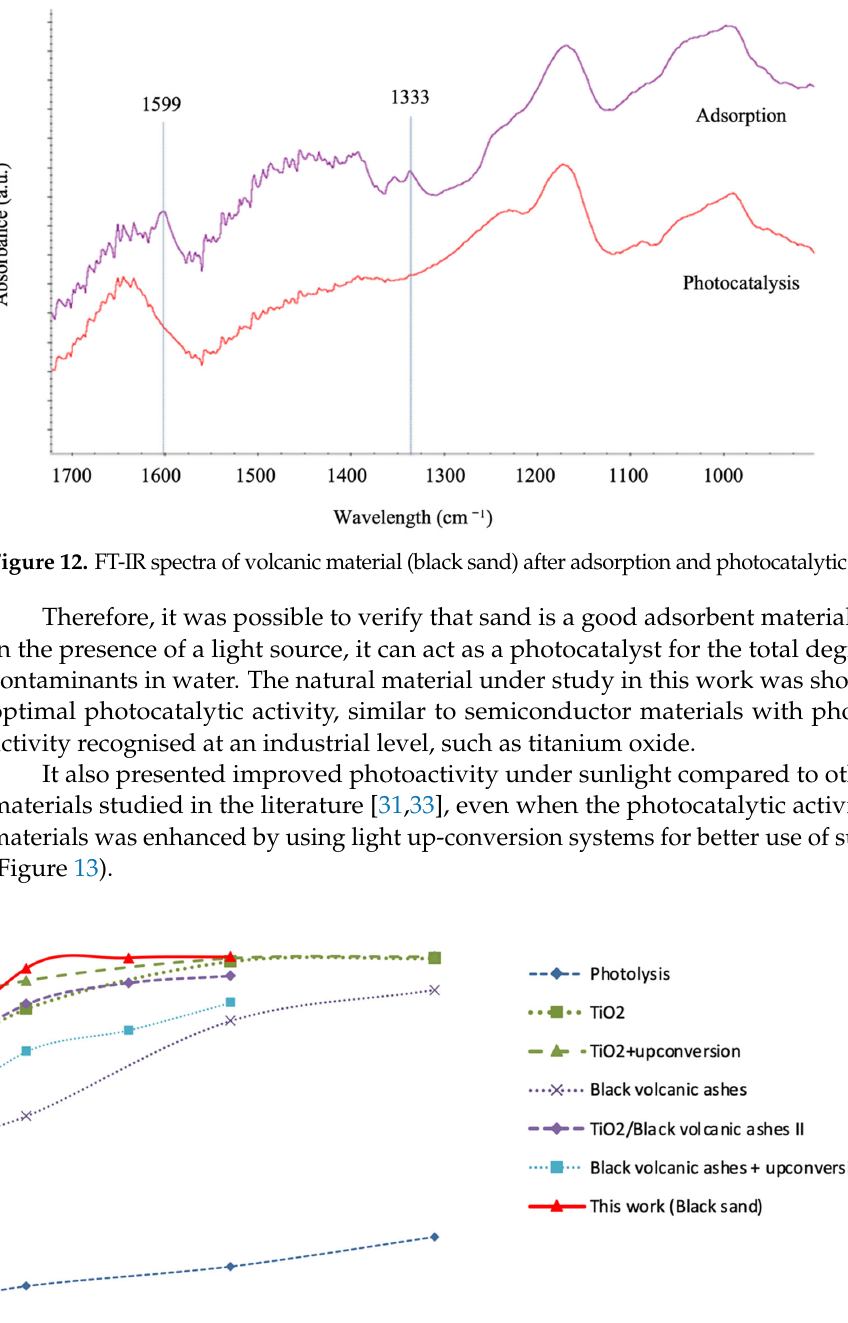
11 of 15 Figure 11. Pollutant in wastewater removal/degradation by adsorption/photocatalysis. The photocatalytic degradation of the contaminant due to the activation of the pho ‐ tocatalytic material by the input of light can be distinguished from the adsorption phe ‐ nomenon by analysing the presence of the contaminant (MB) on the catalytic surface. Fig ‐ ure 12 shows the FT ‐ IR spectra of the black volcanic sand used for the pollutant adsorption experiments and the materials used as photocatalysts for the pollutant degradation exper ‐ iments. As seen in the spectra obtained for both materials, the spectrum of the material used in the adsorption experiments (without light) showed characteristic peaks corre ‐